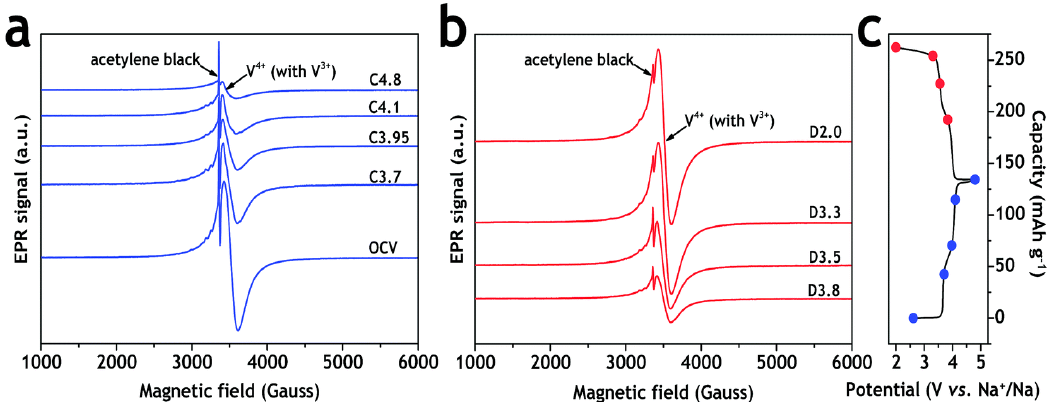
Figure 4. ( a ) EPR spectrum of Na 3 V 2 (PO 4 ) 2 O 1.6 F 1.4 during the charging process. The EPR signal representing V 4+ (t 2g 1 e g 0 , S = 1/2) gradually diminishes during charging and does not disappear completely when charging to 4.8 V. ( b ) EPR spectrum of Na 3 V 2 (PO 4 ) 2 O 1.6 F 1.4 during the discharging process. The EPR signal of V 4+ is gradually enhanced back to the initial level during the discharge. The spin state of V 3+ in the spectrum is t 2g2 e g0 , S = 1. Measured at X band. ( c ) The blue and red dots correspond to the potential of the battery when the spectral line in figure ( a , b ) is obtained. Reproduced with permission from ref. [55]. Copyright 2018, copyright Royal Society of Chemistry.